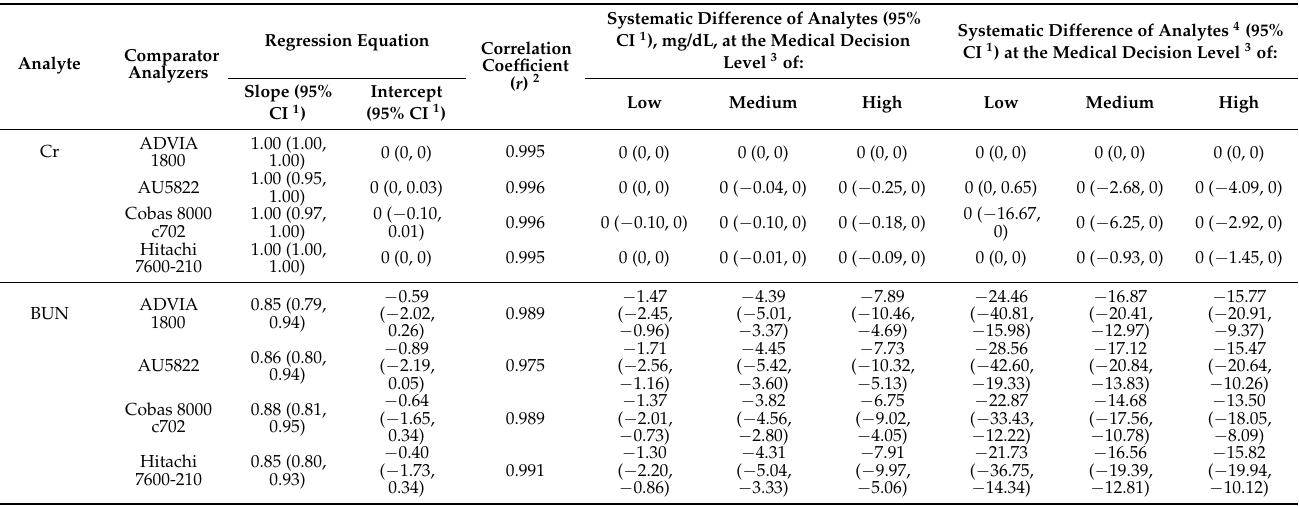
Table 3. Passing–Bablok regression and systematic differences between the four automated chemistry analyzers and the ABL90 FLEX PLUS using serum for Cr and BUN testing.